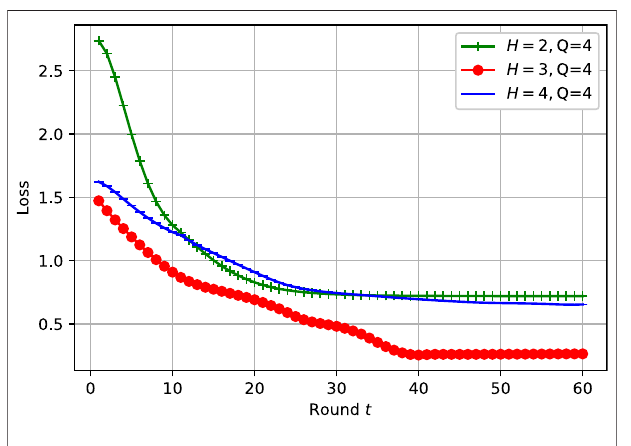
FIGURE3| Differentnumber oflayerscon fi gurationscomparison for η (cid:1) 0.001.